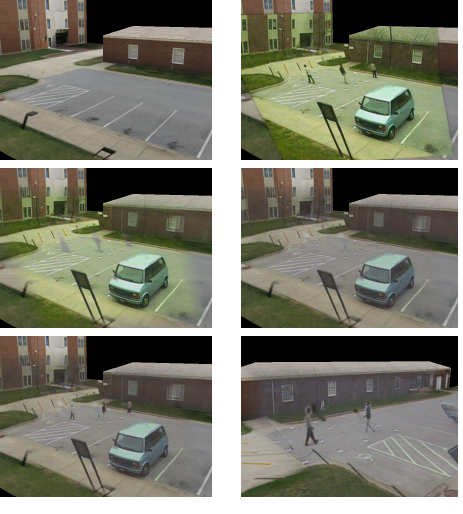
Fig. 7. Steps for generating free view video from sparse cameras